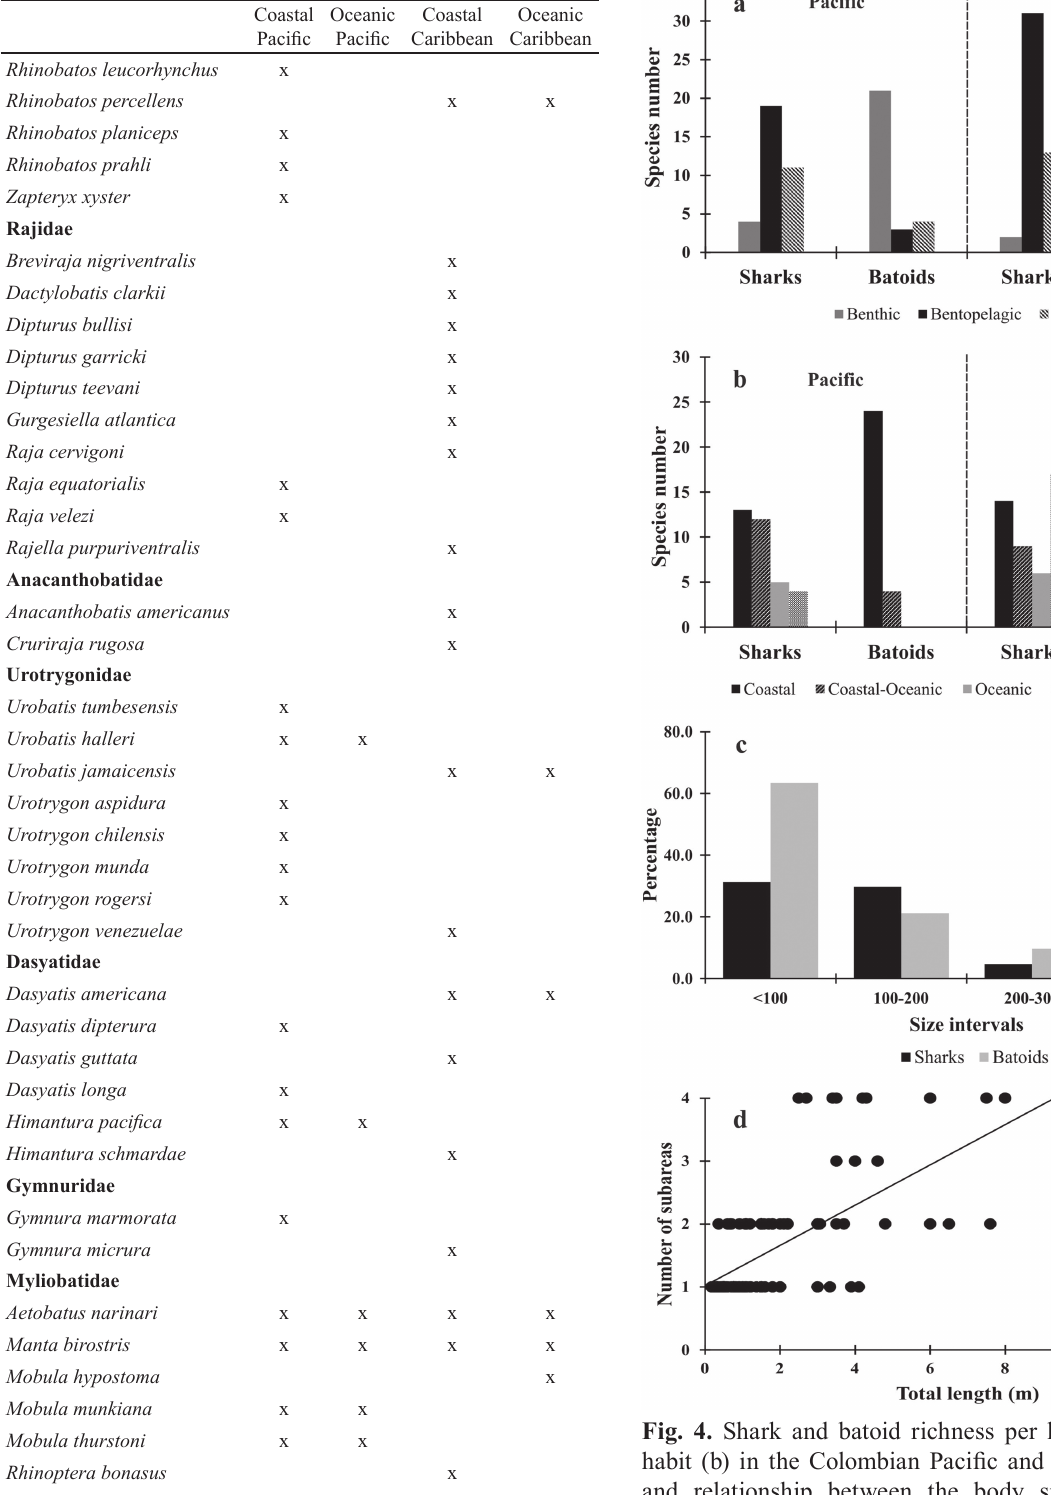
Table 1. (conclusion).